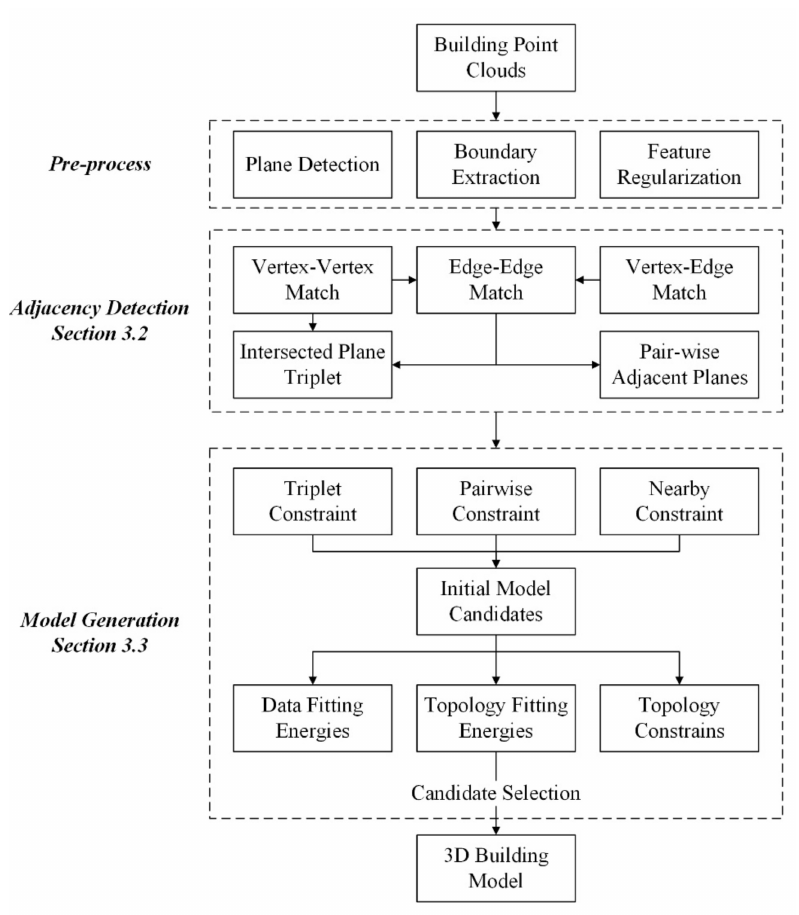
Figure 1. Overall workflow of the proposed